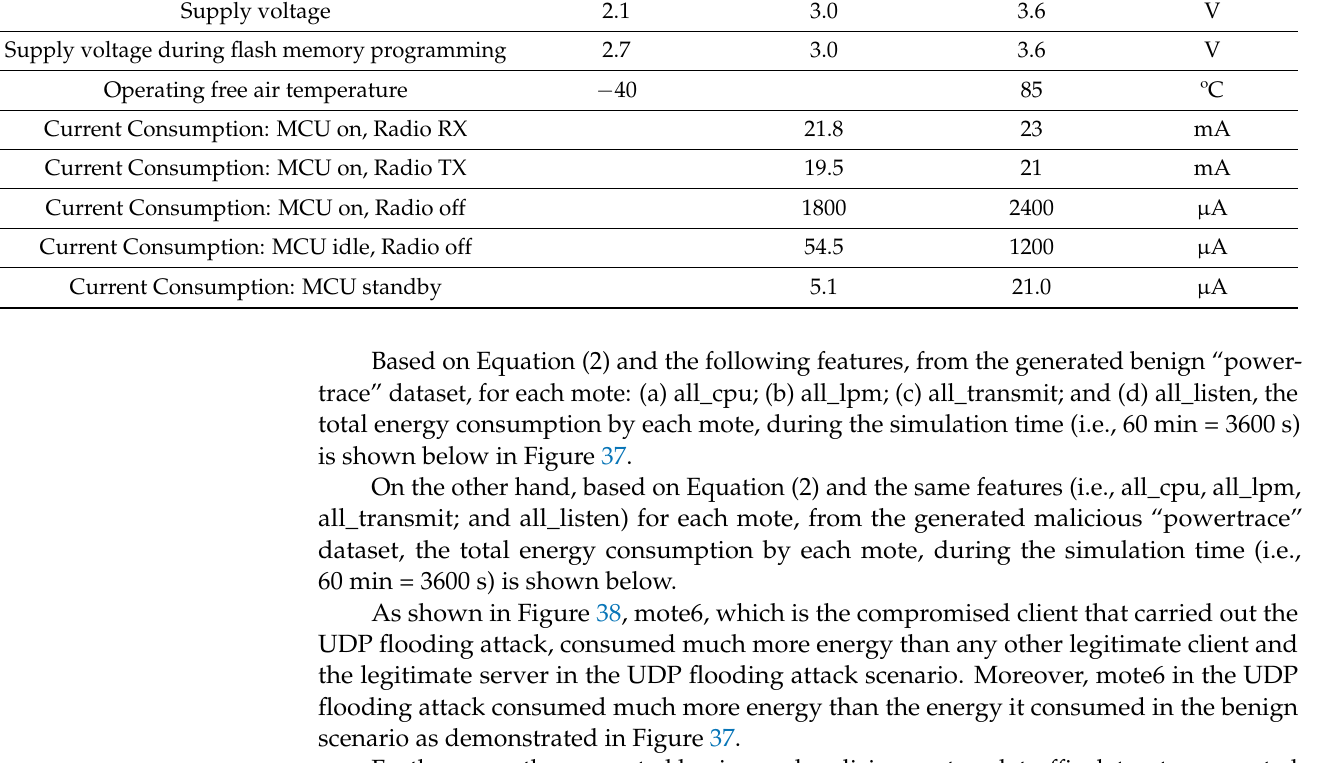
Table 2. Typical Operating Conditions for Tmote Sky motes. MIN NOM (Typical) MAX